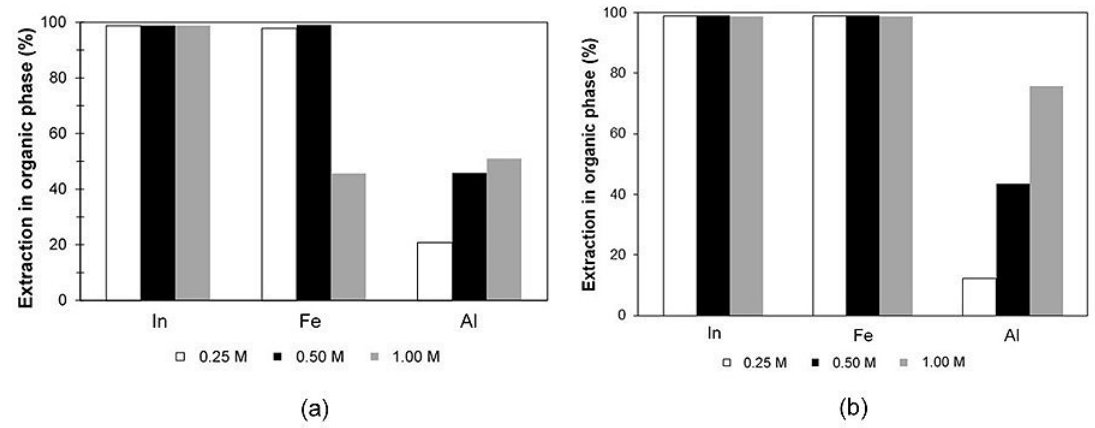
Figure 8. ( a ) Recovery of In, Fe, and Al with DEHPA and diesel; ( b ) Recovery of In, Fe, and Al with DEHPA and n -hexane.